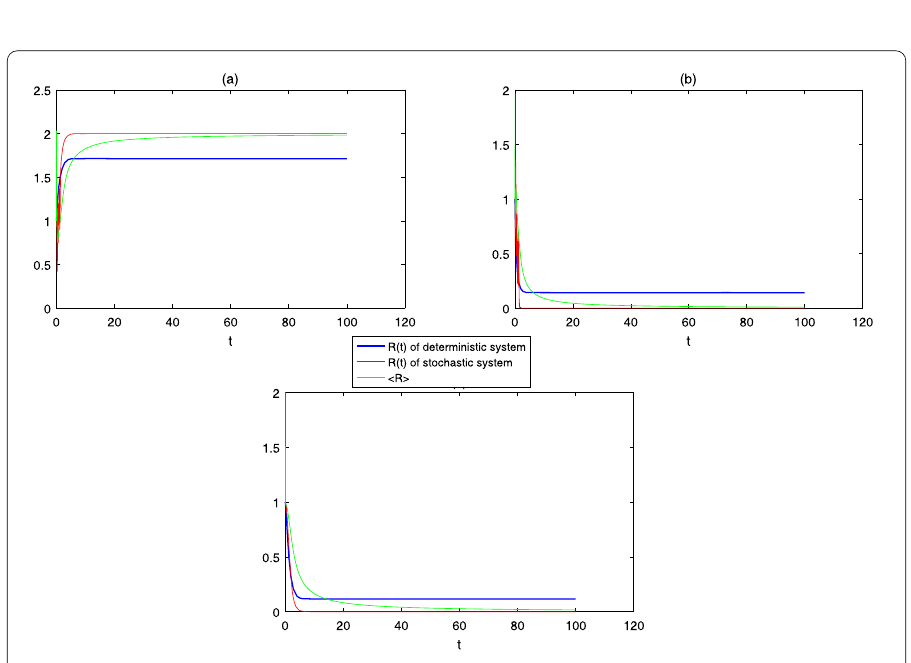
Figure 4 Comparison of the deterministic system and the stochastic system, with (cid:2) = 2, α = 0.2, β = 2, a = 1, μ = 1, r 1 = 0.9, r 2 = 0.9, δ = 0.1, σ = 1.2, where R 0 = 1.3333 > 1